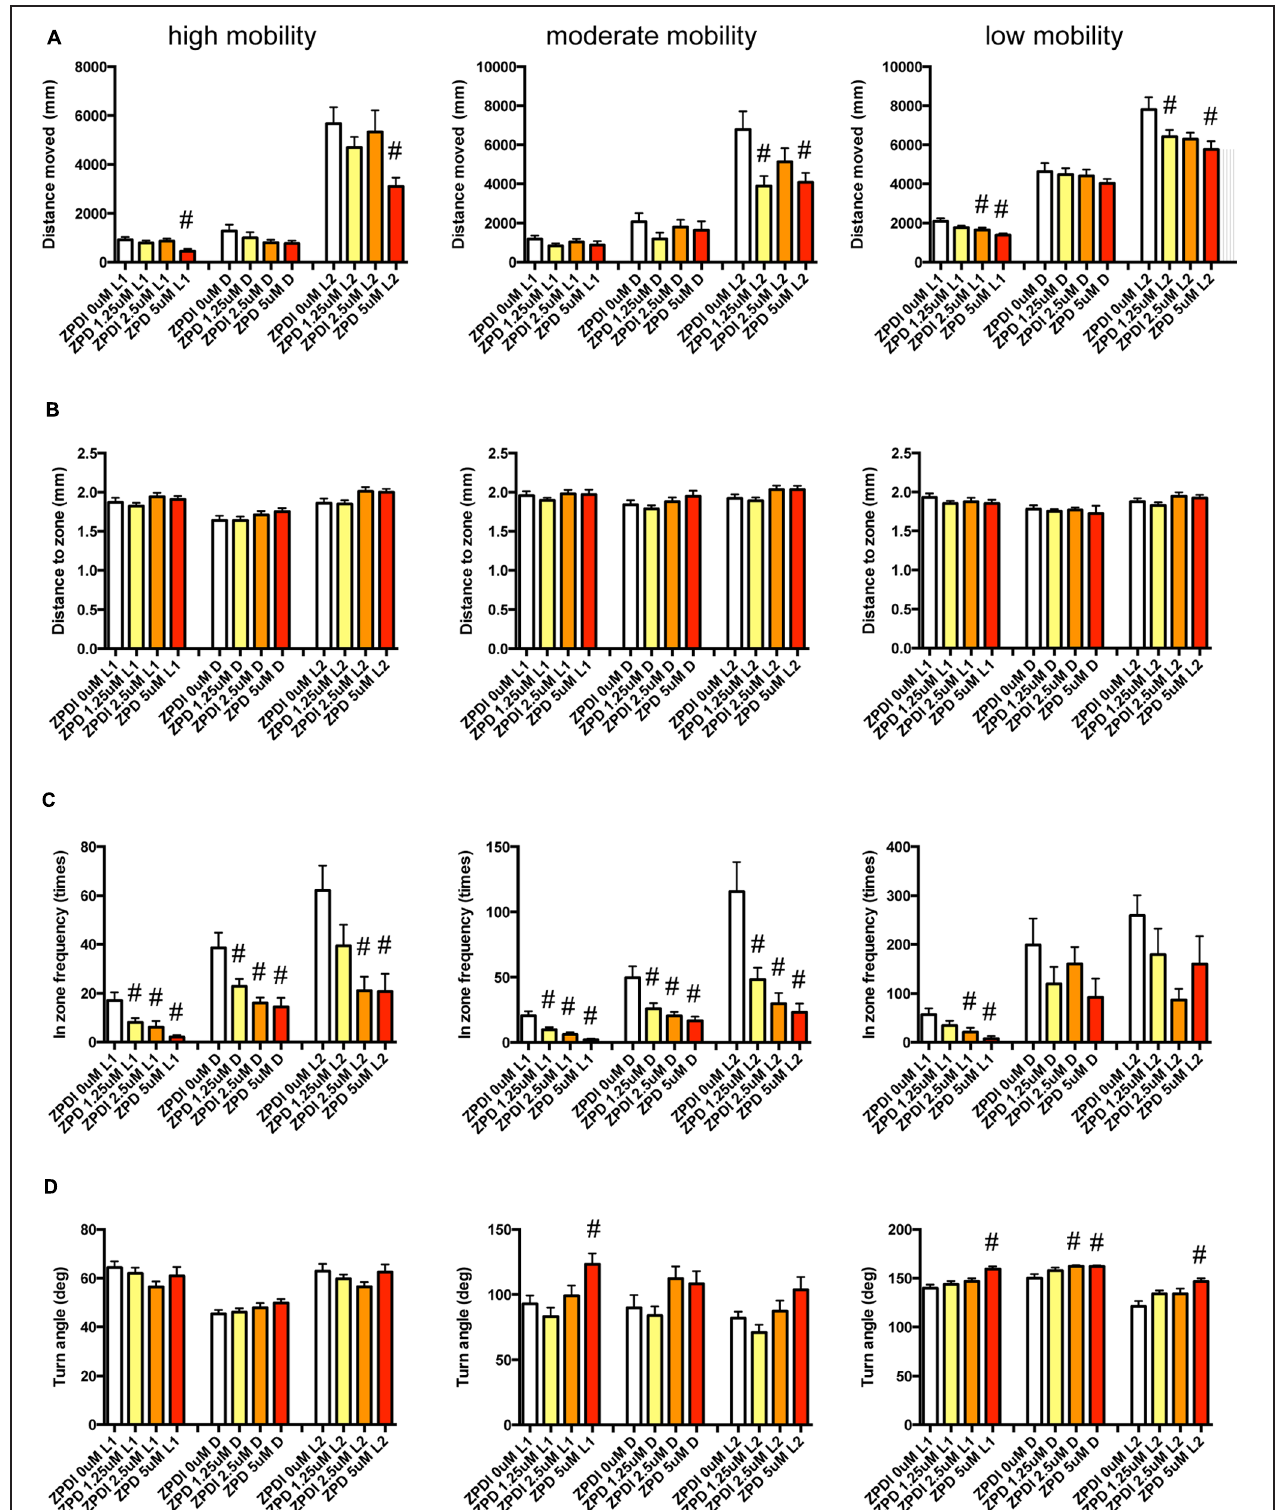
FIGURE 7 | Behavioral profiling of zebrafish treated with zolpidem. The behavior of zebrafish treated with zolpidem from 9 to 10 dpf are classified into three groups based on their mobility. Distance moved (A) , distance to zone (B) , in-zone frequency (C) , and turn angle (D) at L1, D, and L2 periods are shown for each mobility classification. The data are represented as means with the standard error of mean. # p < 0.05 vs. 0 μ M.